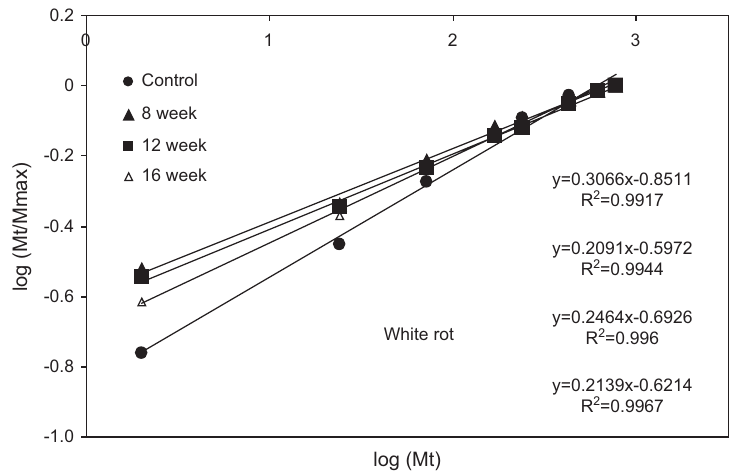
Figure 2 Diffusion case fitting for BF/PP composites against white-rot fungi at different exposure times.